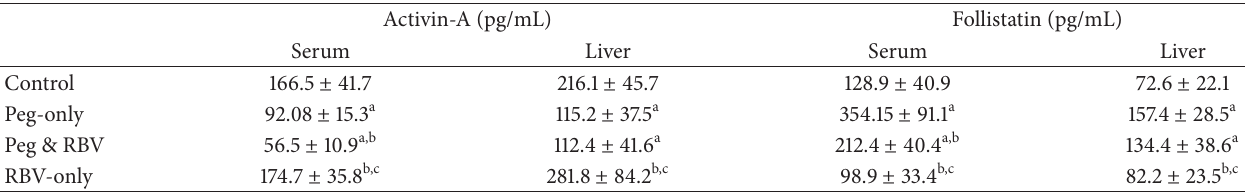
Table 4: Mean ± SD of serum and liver concentrations of activin-A and follistatin in the different